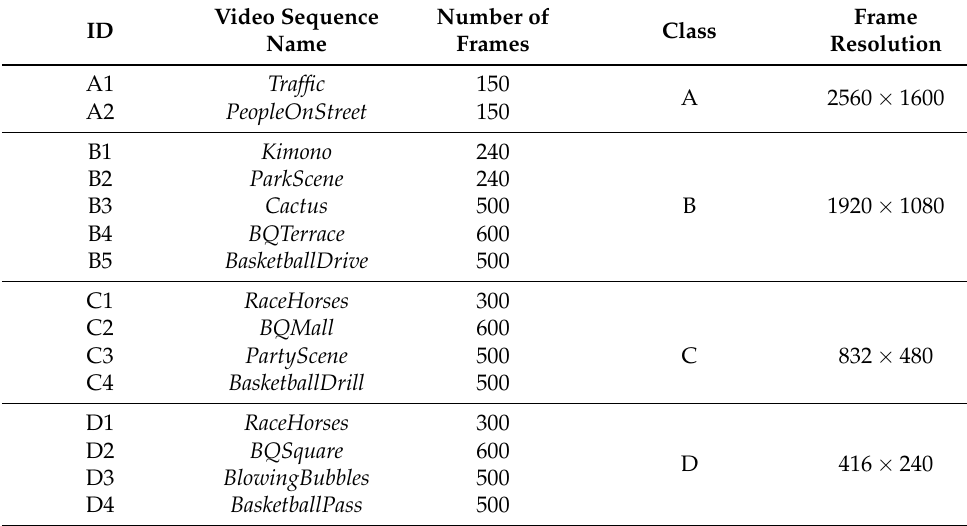
Table 2. HEVC-VTSEQ: the Common-Test Dataset [56]. Video Sequence ID